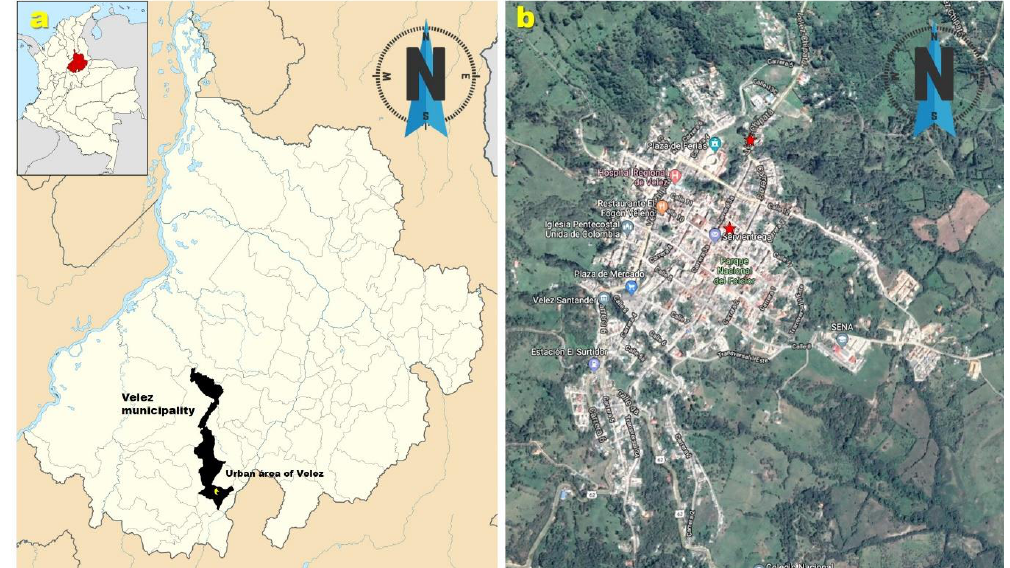
Figure 1. ( a ) Location of the municipality of Velez (Santander), Colombia, and its urban area. ( b ) Satellite image of the urban area of Vélez, showing the sampling localities indicated by red stars (adapted and modified from Google Maps [48]).